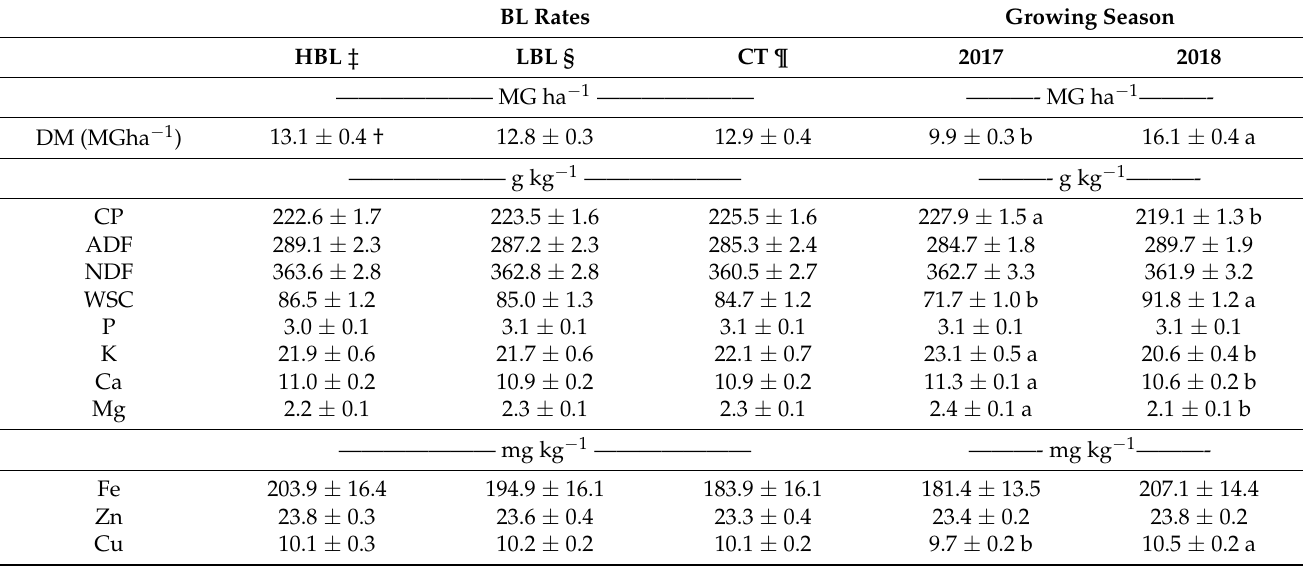
Table 4. Alfalfa dry matter production and forage quality in 2017 and 2018 by the BL